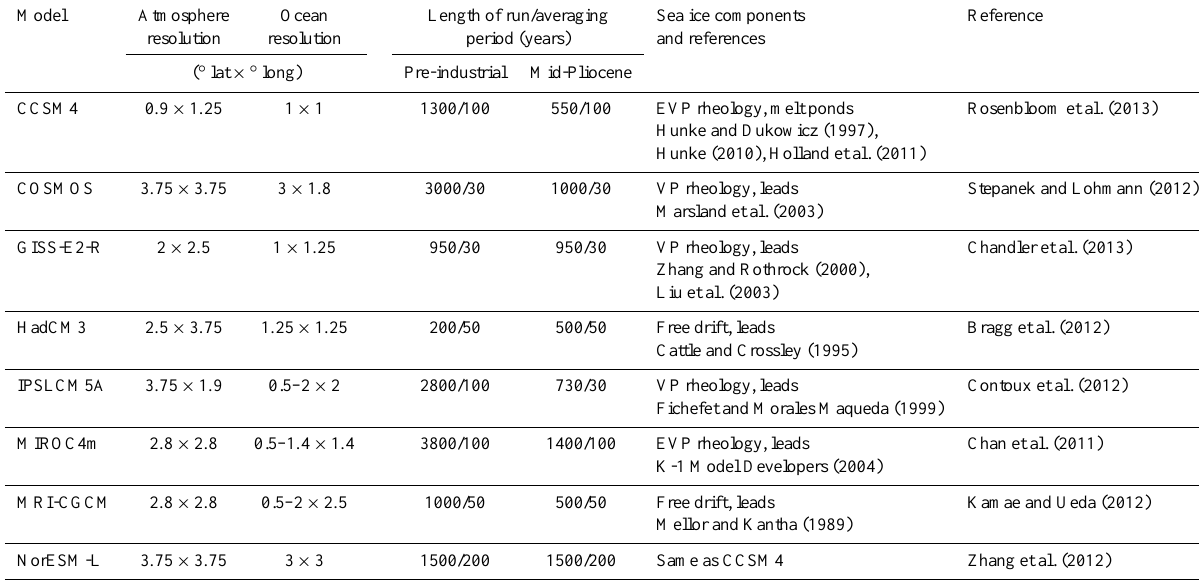
Table 1. Technical details of the PlioMIP model ensemble: atmosphere and ocean resolutions, details of the sea ice component, and references for each of the eight PlioMIP Experiment 2 simulations.